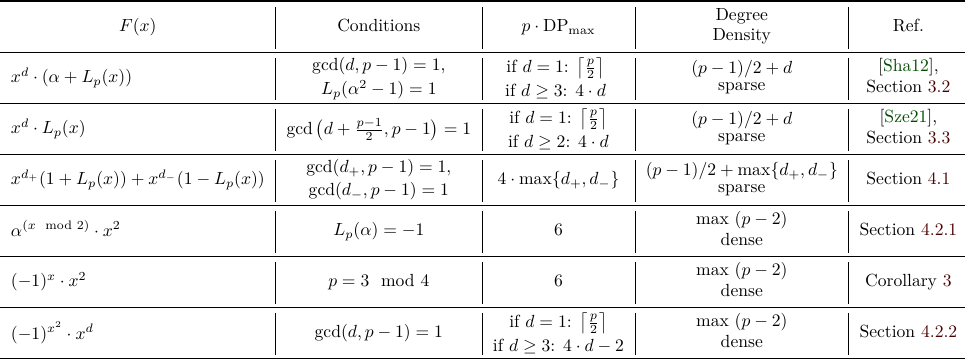
Table 1: Summary of the proposed invertible functions F over F p and their statistical and algebraic properties. Note that algebraic properties refer to their polynomial